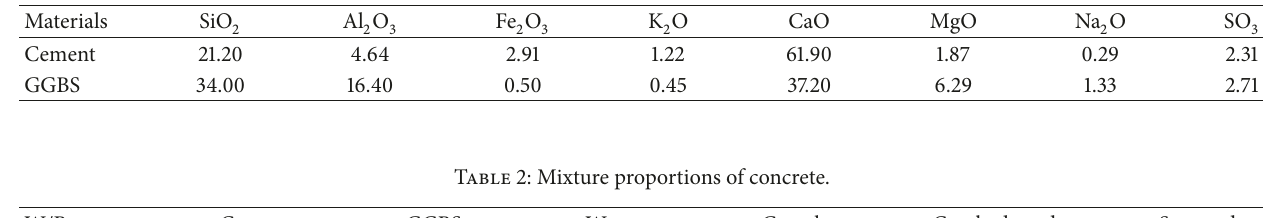
Table 1: Chemical composition of Portland cement and GGBS.